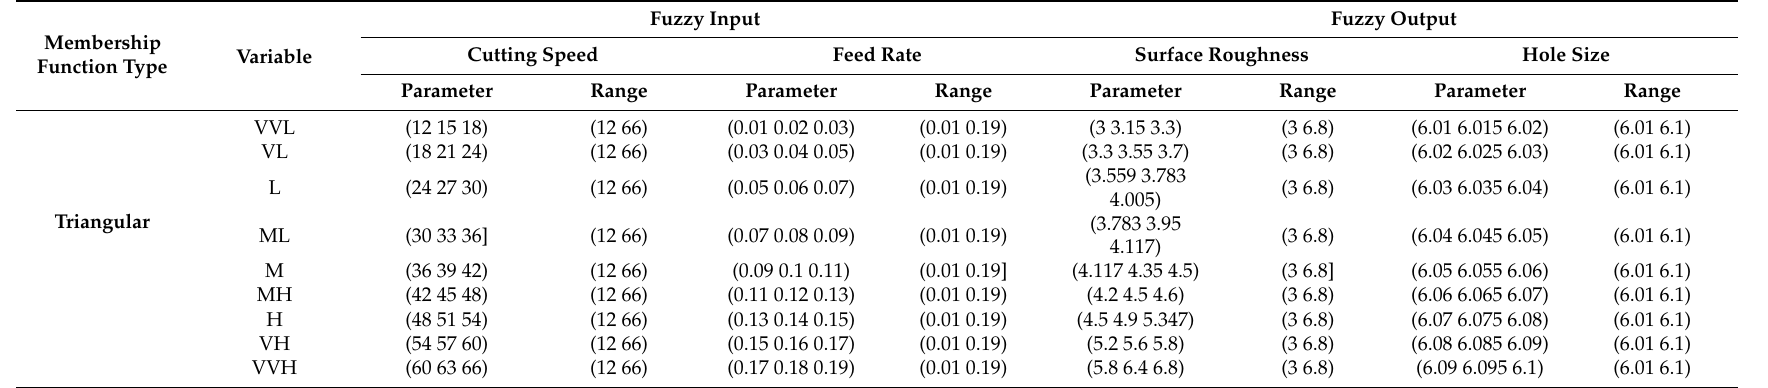
Table 9. Parameter of fuzzy inference system with membership functions and variables. VVL: very very low, VL: very low, L: low, ML: moderately low, M: medium, MH: moderately high, H: high, VH: very high, VVH: very very